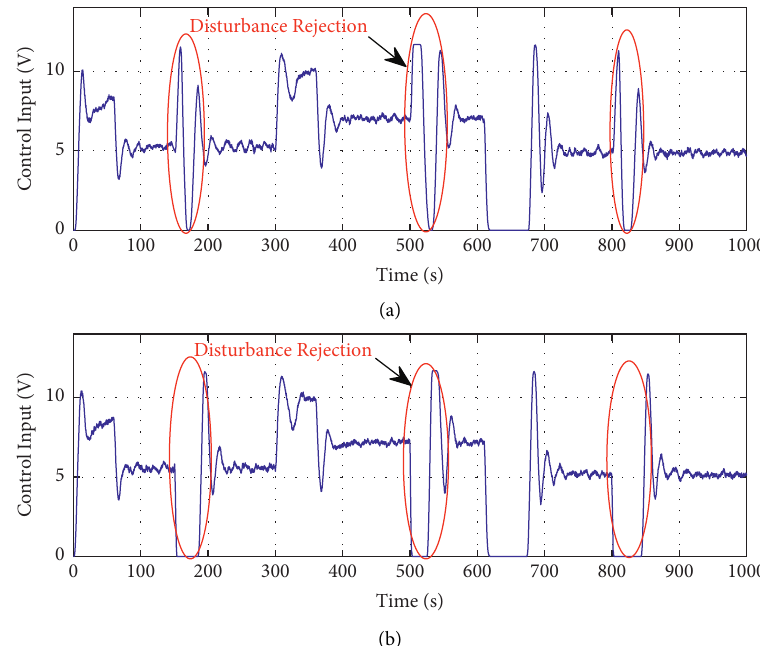
Figure 15: IB voltage with disturbances rejection. (a) With the reaction of rejecting the external disturbance; (b) with the reaction of rejecting the parameter